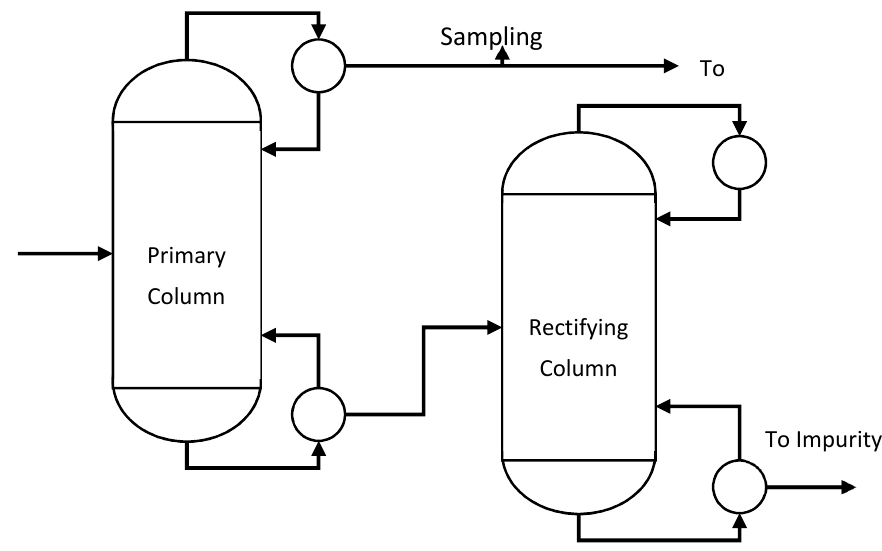
Figure 2. Process flow diagram of the refining section of the production process.